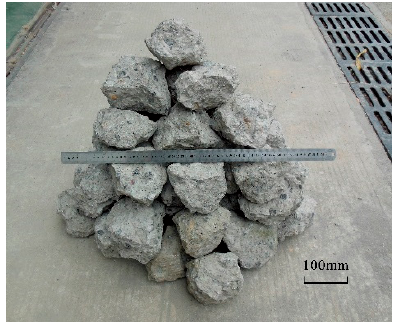
Figure 3. Demolished concrete lumps (DCLs).